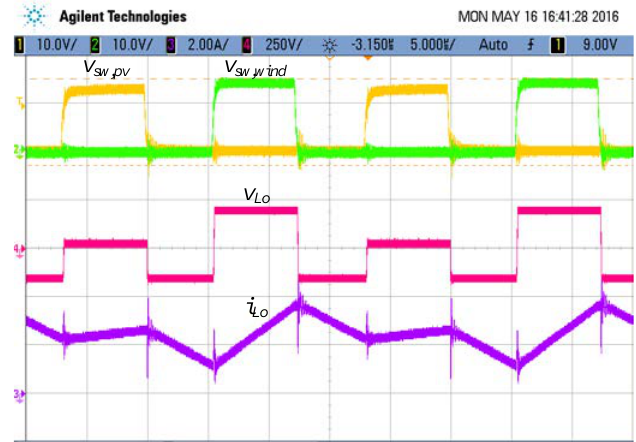
Figure 8. Measured waveforms while the DIPWC is operated at full load ( v sw,wind : 10 V/div, v SW,pv : 10 V/div, v Lo : 250 V/div, i Lo : 2 A/div, time: 5 μs/div).